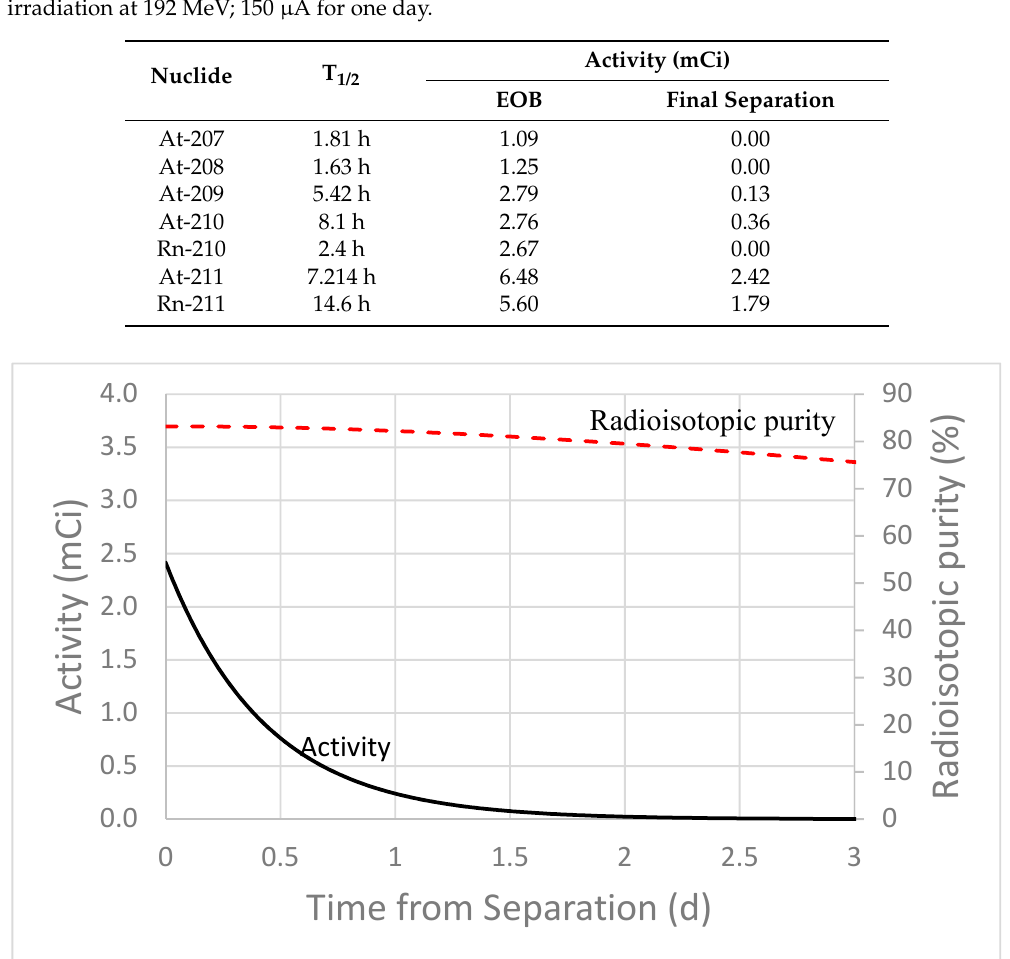
Figure 5. MCNP6 and experimentally calculated radioisotopic purity of At-211. Calculations assume astatine purified from Ac-225 waste streams and irradiation parameters specified in the caption for Table 5.